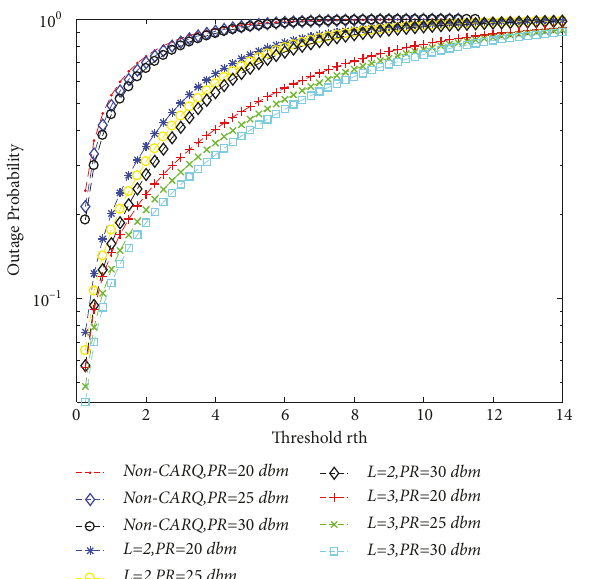
SRD th vs Pr ( out ,l ) with different